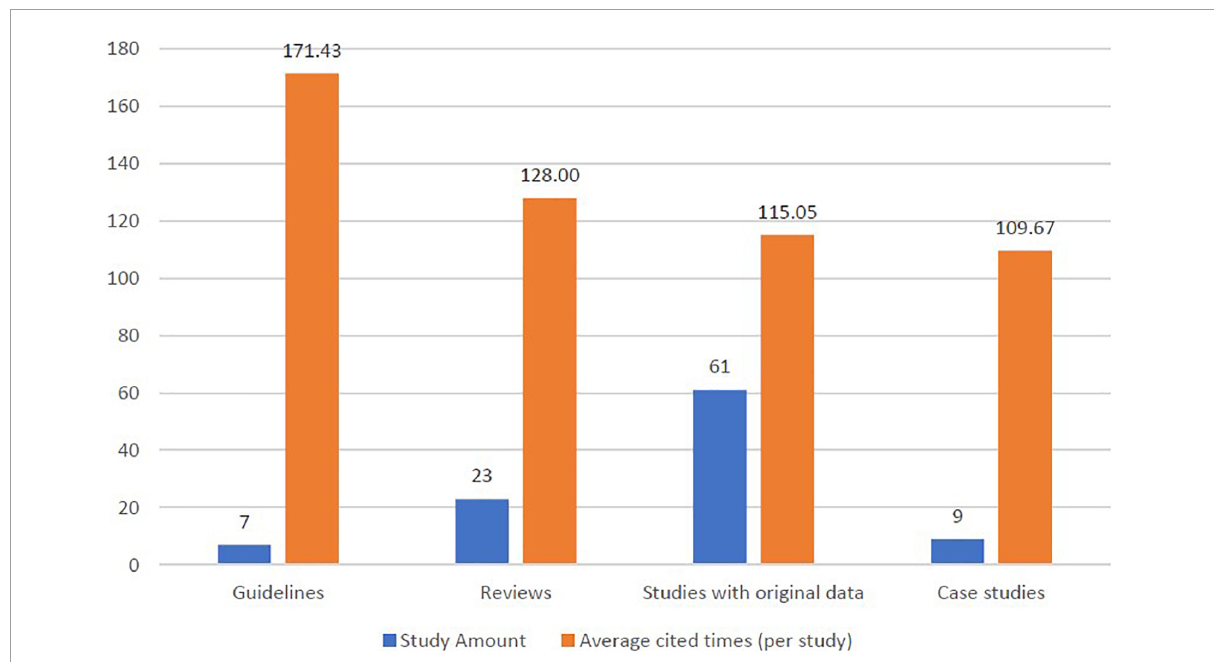
FIGURE4 Distribution of study designs and cited amount (per study) in the top 100 publications of pemphigoid